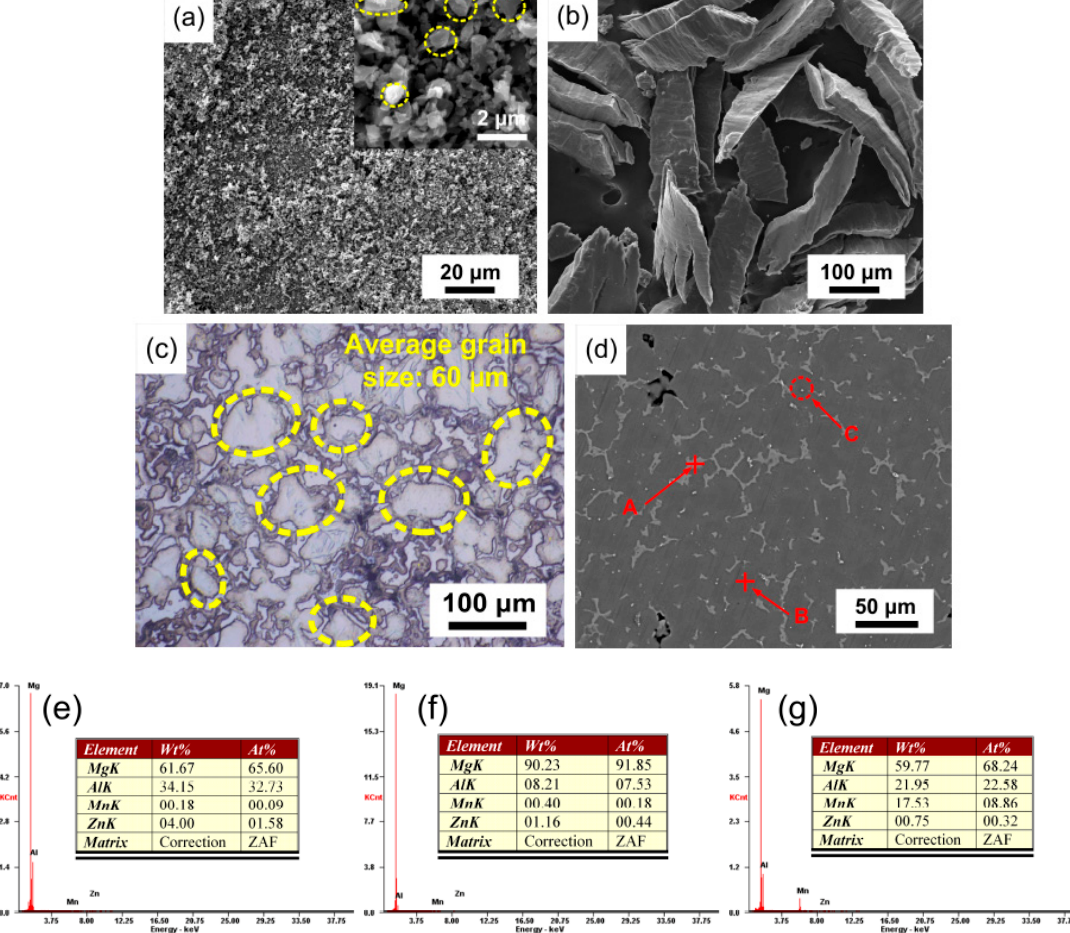
Figure 1. Microstructure of initial materials: ( a , b ) morphology of SiCp powders and AZ91 chips; ( c , d ) optical microscope (OM) and scanning electron microscope (SEM) images of AZ91; ( e – g ) energy-dispersive spectrometer (EDS) results of points A, B, and C in Figure 1d.